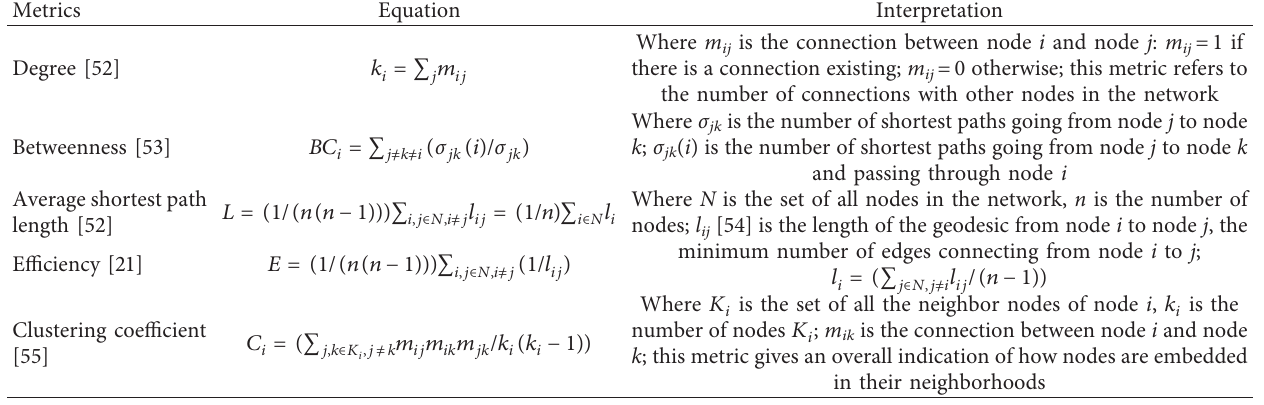
Table 1: Most frequently used topological metrics in air transport